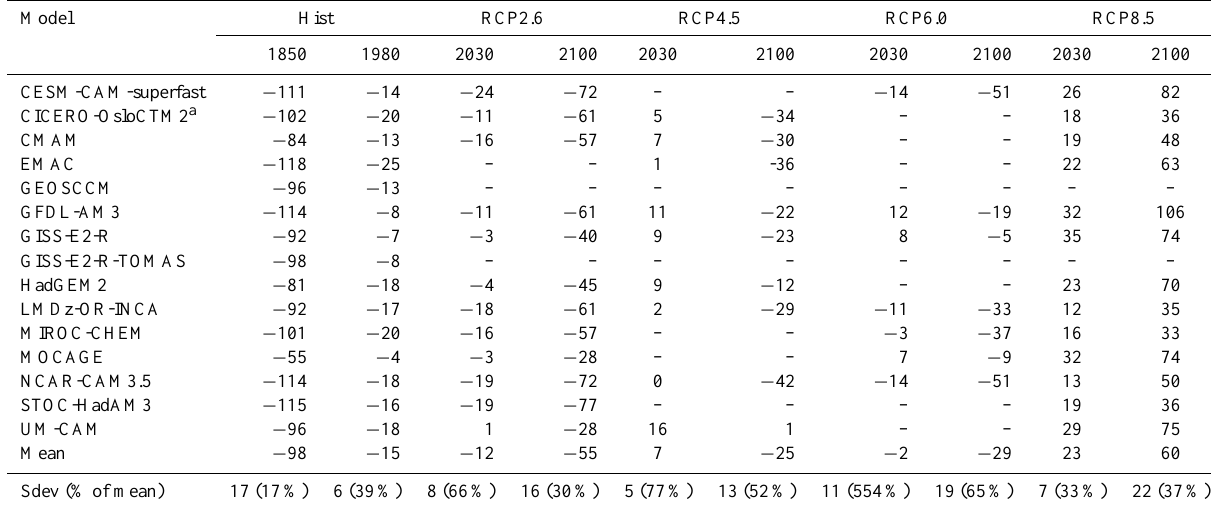
Table 5. Differences in the tropospheric ozone burden compared to Hist 2000, using data in Table 1.